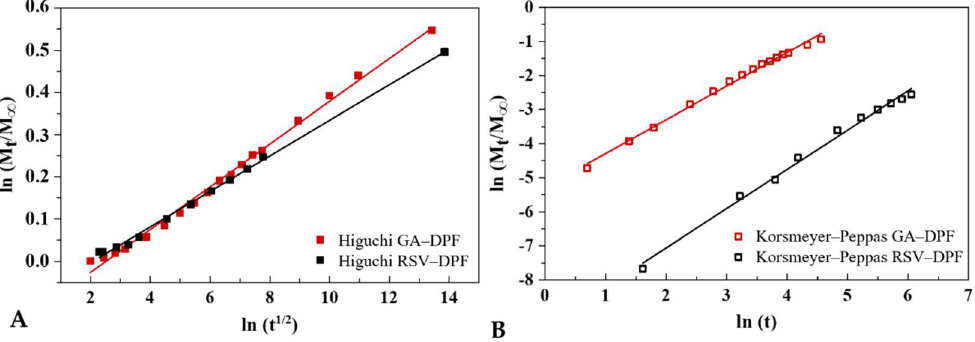
Figure 12. RSV and GA release profile from RSV–DPF and GA–DPF microparticles by ( A ) Higuchi and ( B ) Korsmeyer–Peppas mathematical models.